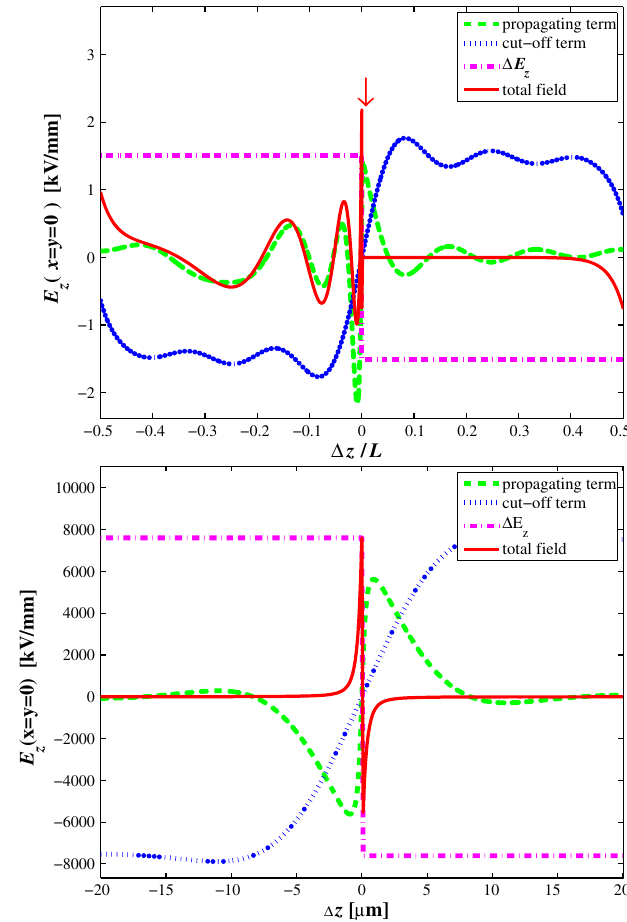
FIG. 4. (Color) Spatial (longitudinal) dependence of the forward (top) and backward (bottom) field amplitude (30) of TM in the vicinity of the cutoff.